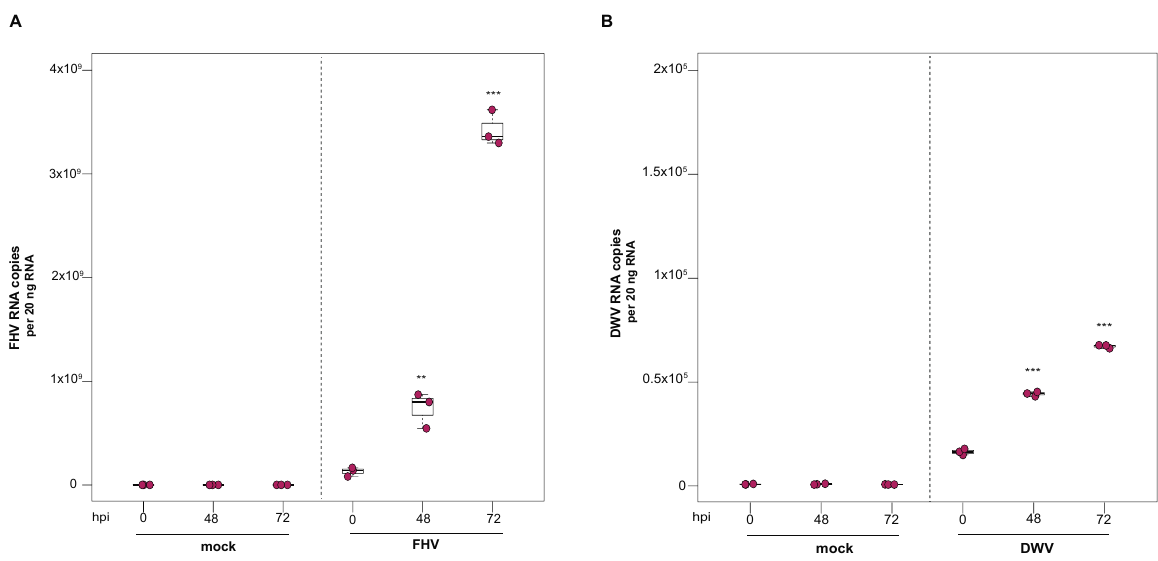
Figure 6. DWV and FHV infection transferred from infected to naïve honey bee pupal cells. To confirm that infectious DWV and FHV virions were produced in infected primary honey bee pupal cells, mock- or virus-infected honey bee pupal cell cultures (10 µ L) at 72 hpi were transferred to naïve pupal cells. Virus abundance was assessed over a time course (i.e., 0 hpi, 48 hpi, and 72 hpi) using qPCR. Raw data are included in Supplemental Tables S7 and S8. ( A ) FHV abundance increased 15.8 × at 48 hpi ( p = 0.003), with a subsequent 28 × increase at 72 hpi relative to 0 hpi ( p < 0.001). ( B ) DWV abundance was 2.7 × ( p < 0.001) higher at 48 hpi and 4.1 × higher at 72 hpi, relative to 0 hpi ( p < 0.001). Figure 6 includes results from one representative biological replicate. The data for additional replicates are presented in Supplemental Figure S6. All differences in means relative to 0 hpi were assessed by a Dunnett’s test. Significance levels: ** p < 0.005; *** p <